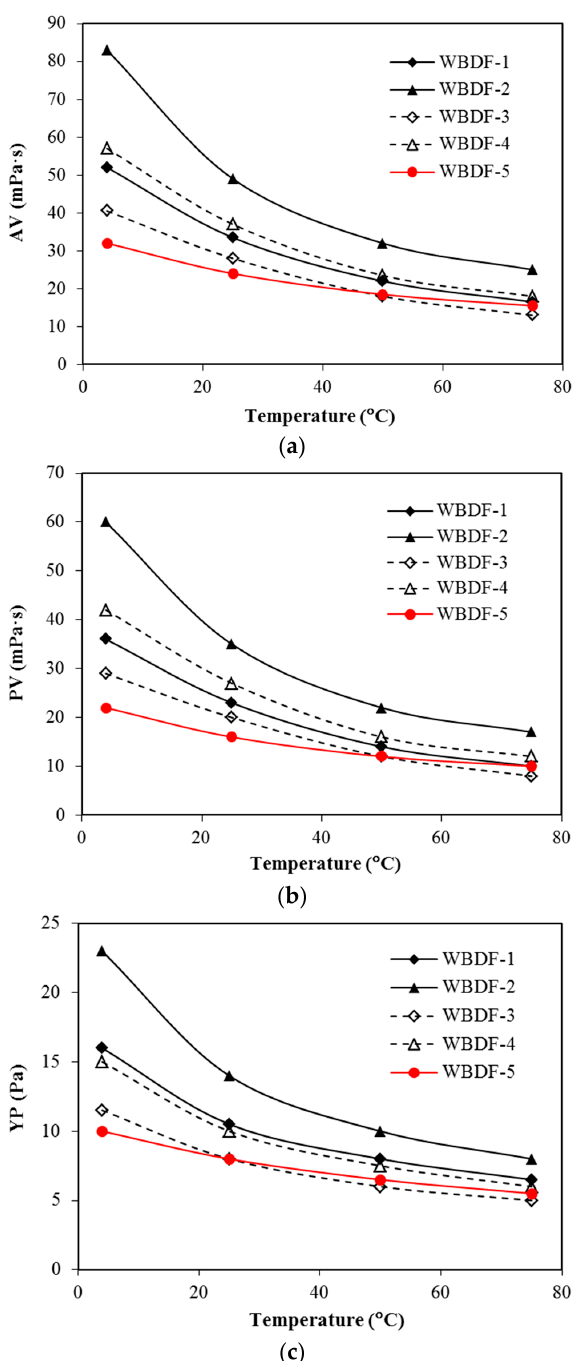
Figure 4. Rheological properties of WBDFs at the temperature range 4–75 °C: ( a ) changes in AV (apparent viscosity) as a function of temperature; ( b ) changes in PV (plastic viscosity) as a function of temperature; and ( c ) changes in YP (yield point) as a function of temperature.